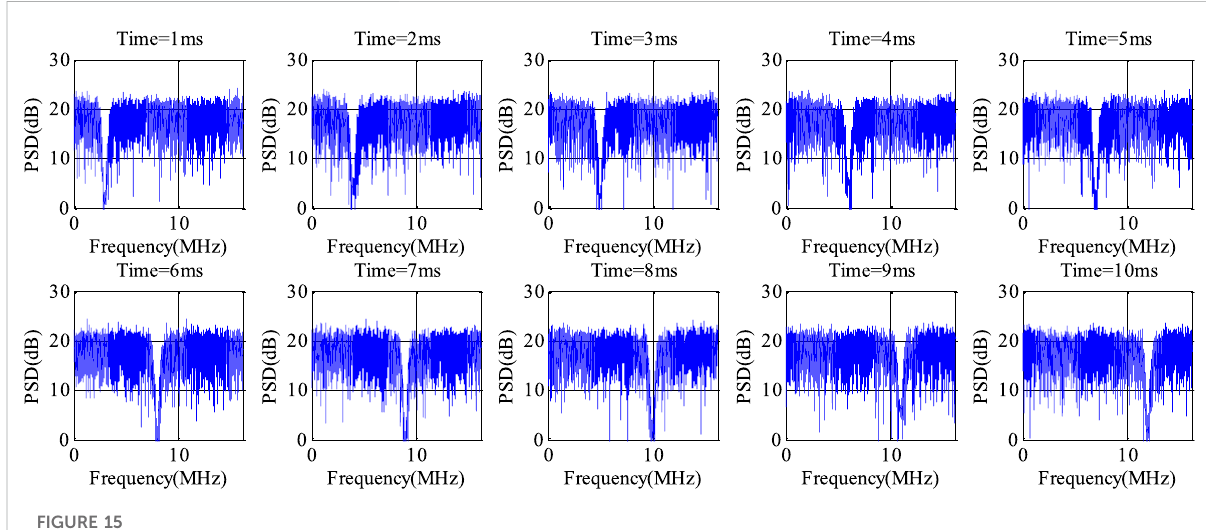
FIGURE 15 Spectral characteristics after anti-jamming based on timing reset